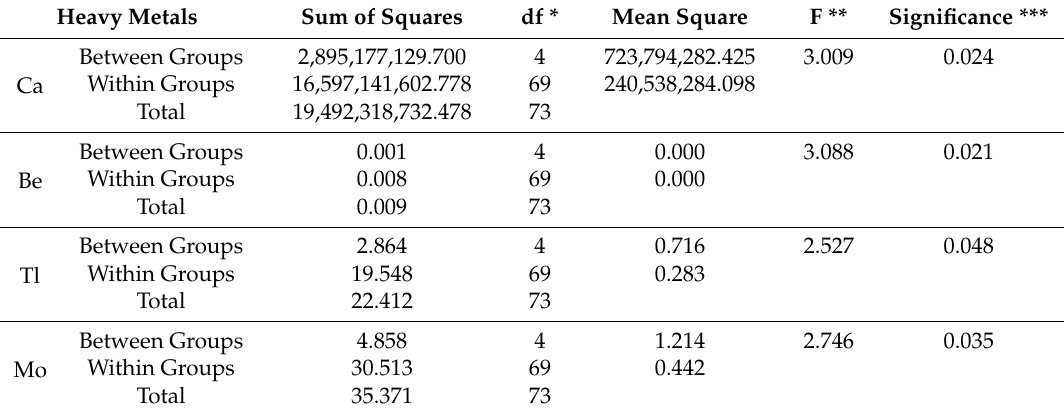
Table 3. One-Way ANOVA comparison of selected heavy metals contamination for different localities in the target